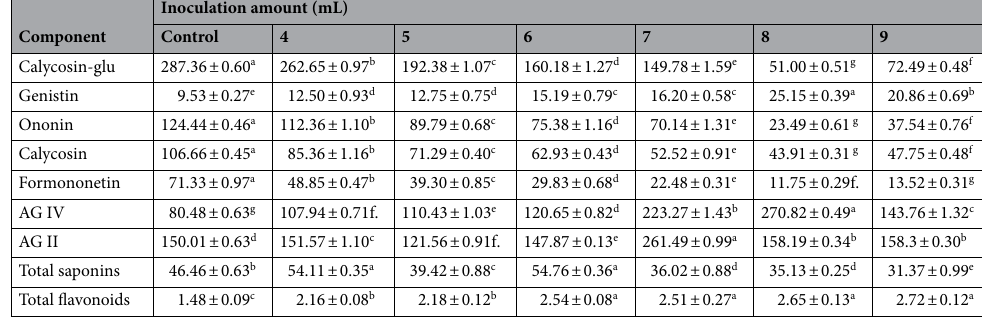
Table 1. Contents of bioactive compounds in inoculation amount. Values are expressed as mean ± standard error from three replications. Means with different superscripts in the same row show significant difference (P < 0.05). Unit of calycosin-glu, genistin, ononin, calycosin, formononetin, AG IV and AG II here is μg/g. Unit of total saponins and total flavonoids here is mg/g.